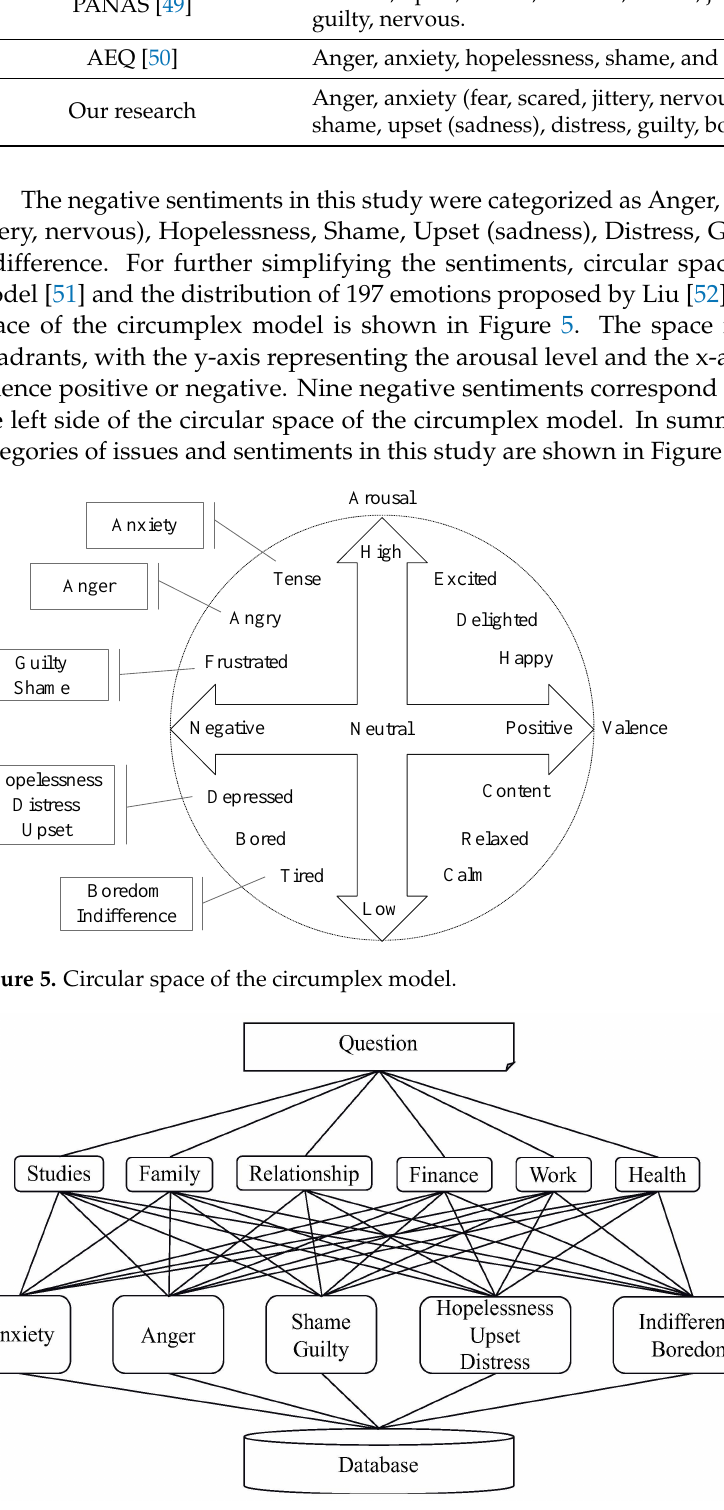
Figure 6. Classes of issues and